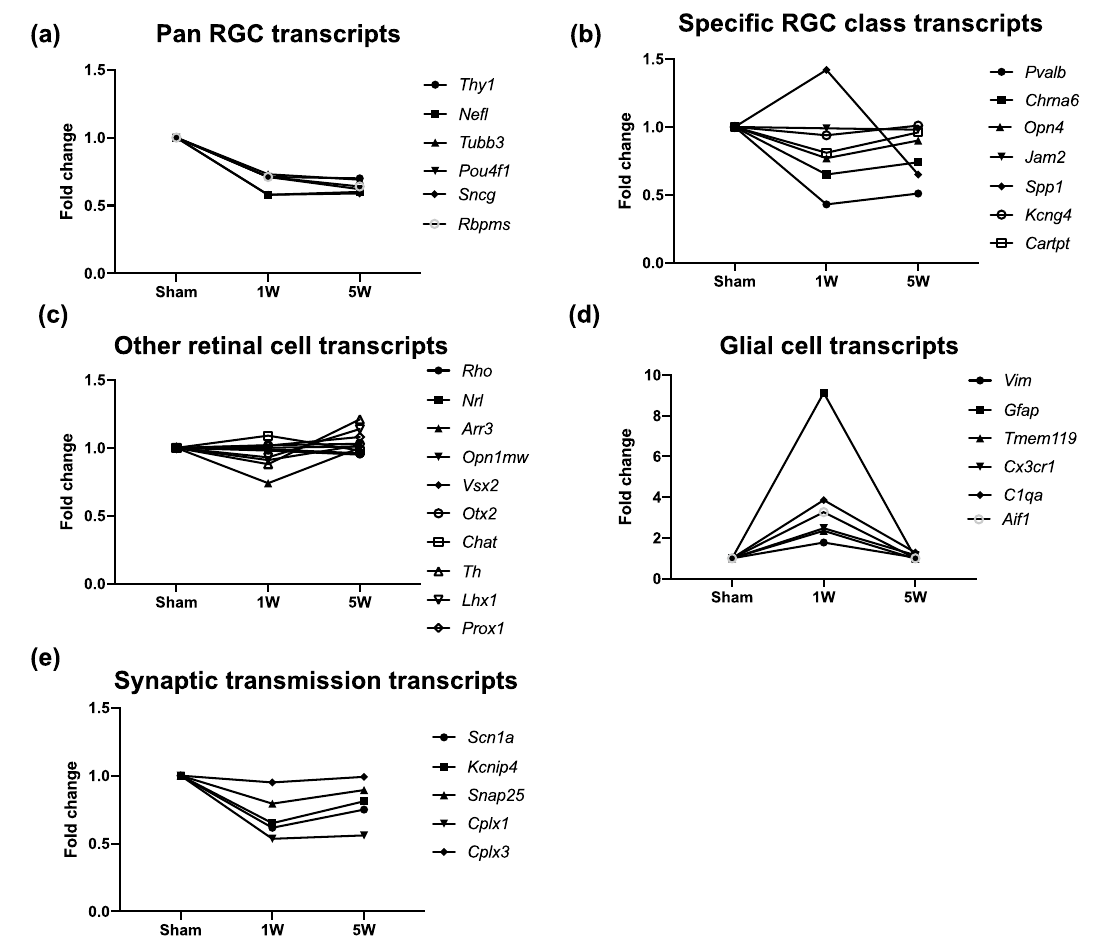
Figure 6. RNA sequencing of the retinal transcriptome shows differences in RGC and glial specific transcripts in bTBI vs. sham retinas. Shown is expression of markers for: ( a ) all RGCs, ( b ) classes of RGCs, ( c ) other types of retinal cells, ( d ) immune cells, and ( e ) synaptic transmission. Affected transcripts of each type are indicated for the corresponding graph. The names of the transcripts and the false discovery rates from RNA sequencing are provided in Table 4. The graphs were generated using WebGestalt 2019 109 and the figure was assembled in Adobe Illustrator CC